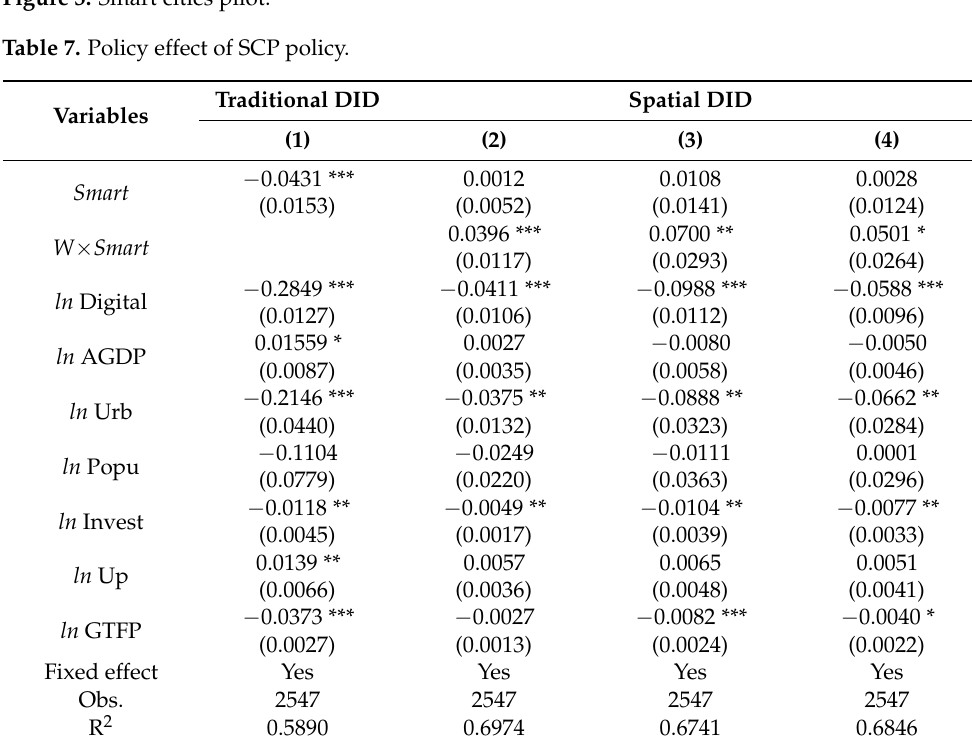
Table 7. Policy effect of SCP policy.